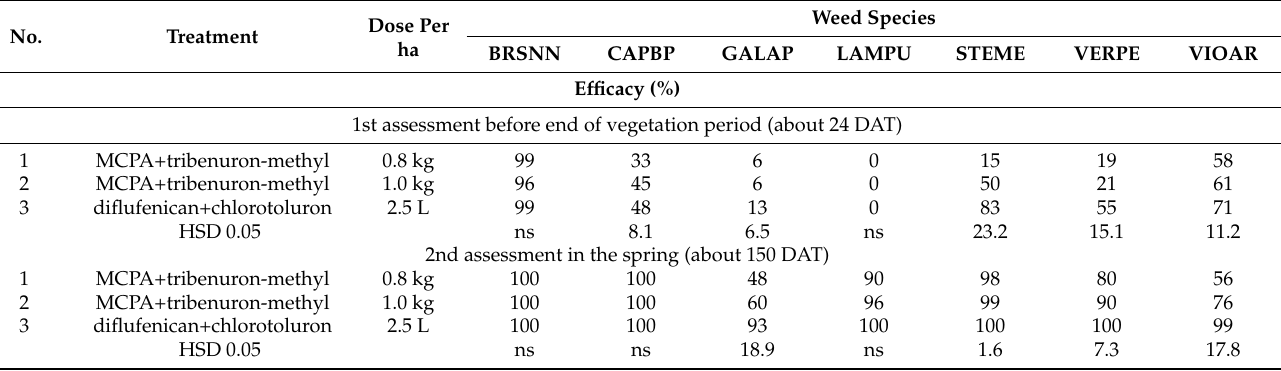
Table 5. Influence of herbicides MCPA+tribenuron-methyl and diflufenican+chlorotoluron applied in autumn on broadleaf weed control in winter cereals in